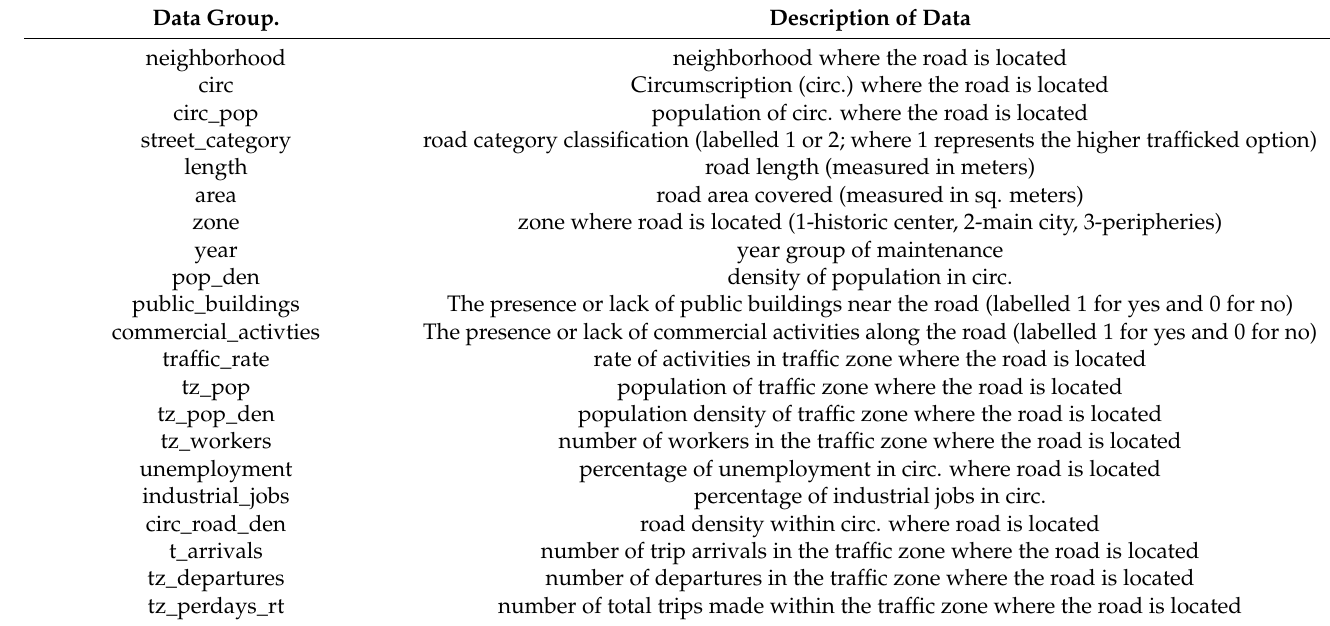
Table 4. Description of features within the